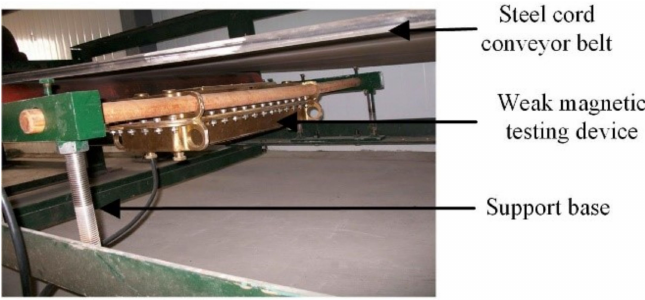
Figure 9. Installing picture of the weak magnetic testing device